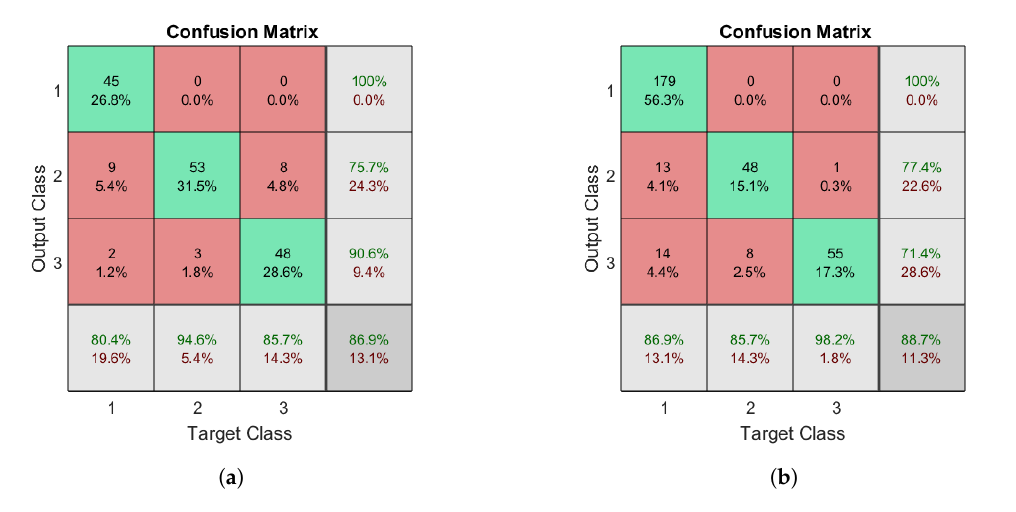
Figure 9. Confusion matrices for multi-class recognition using a DBN: ( a ) the matrix for Dataset A; and ( b ) the matrix for Dataset B. The target classes are as follows: 1, normal; 2, left limp; and 3, right